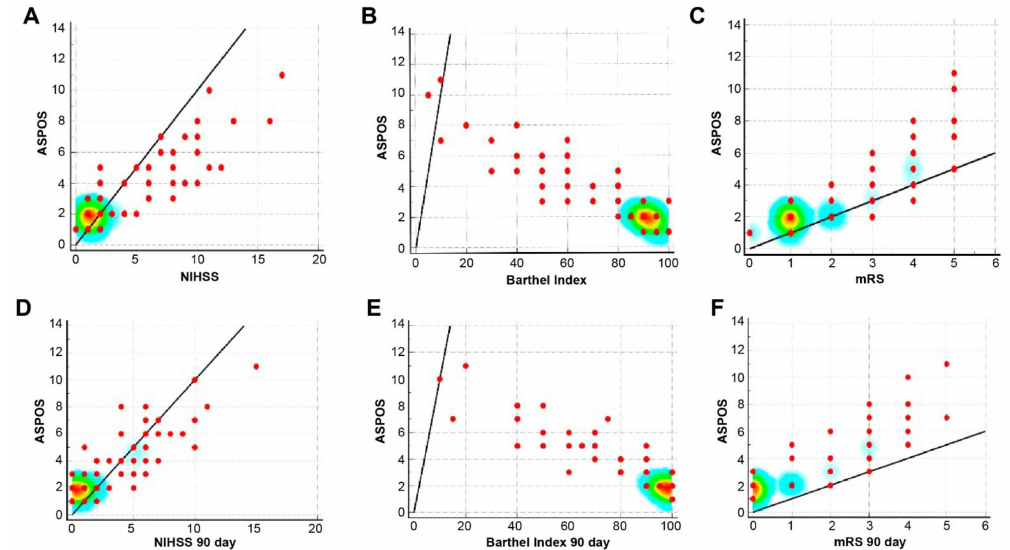
Figure 2. Construct ( A – C ) and predictive ( D – F ) validity of Adam’s Scale of Posterior Stroke (ASPOS). Using an NIHSS value of 6 as the cutoff for stroke severity and qualifying for a thrombectomy, we noted that, in the group with a total ASPOS score of 1 or 2 ( n = 86, 68.2%), no case of NIHSS with at least six points was found. In the group with a total ASPOS score of three points ( n = 9; 7.2%), we reported five cases with an NIHSS total score of six points or more. In the ASPOS group with 4–11 points ( n = 31; 24.6%), 26 cases of NIHSS had six points or more. The Kruskal–Wallis test showed a significant difference between the above groups (H = 78.52; p < 0.0001) (Figure 3). Logistic regression showed that a total ASPOS score of three points indicated a significantly increased probability of a severe stroke based on NIHSS, compared with a total ASPOS of 1–2 points (OR = 141; 95% CI: 6.72–2977.66; p = 0.0014).